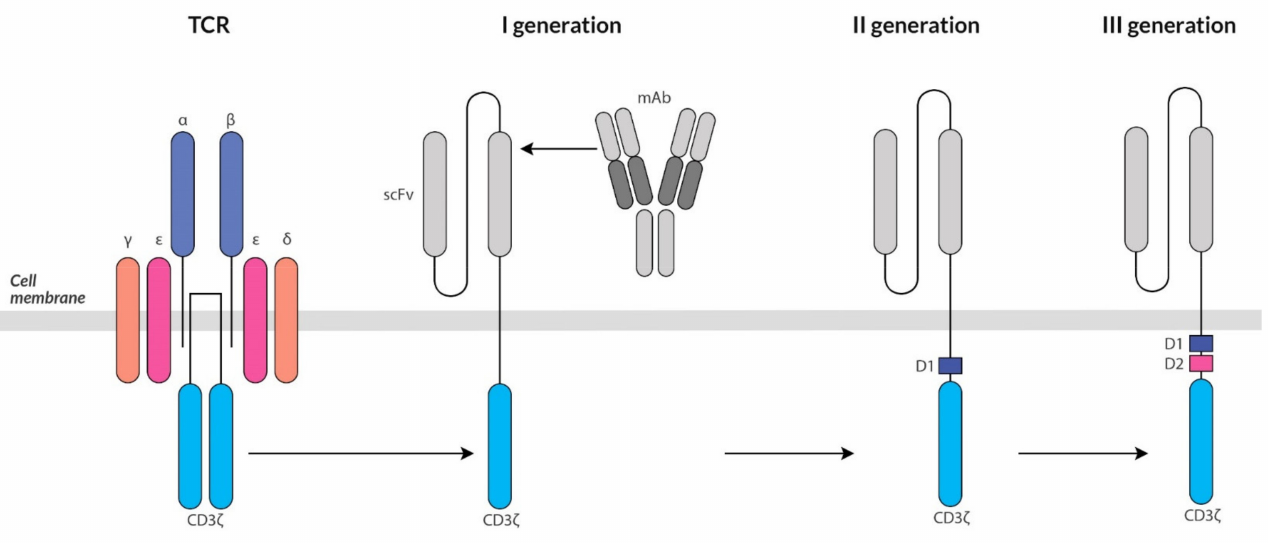
Figure 2. Structure of the first, second and third generation chimeric antigen receptors (CAR) constructed from the variable scFv fragment of a monoclonal antibody and from the cytoplasmic CD3 ζ fragment of the T lymphocyte receptor (TCR). D 1 and D2—costimulatory